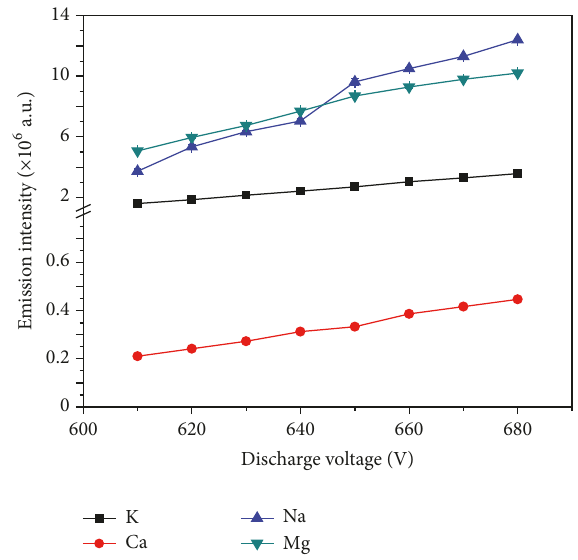
Figure 3: Effect of discharge voltage on emission intensity (con- centration: 5 mgL −1 adjusted to pH = 1.0 with HNO 3 , flow rate: 3 mLmin −1 , interelectrode gap: 2 mm, and capillary diameter: 1mm).